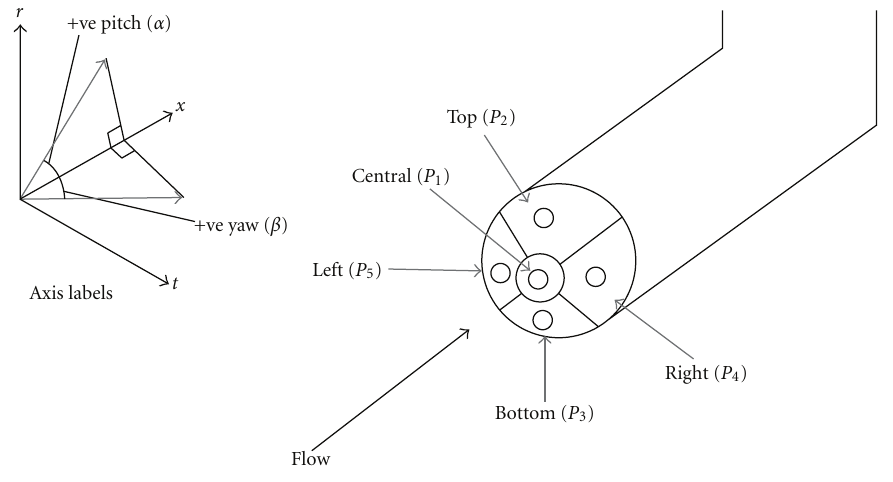
Figure 1: Five-hole